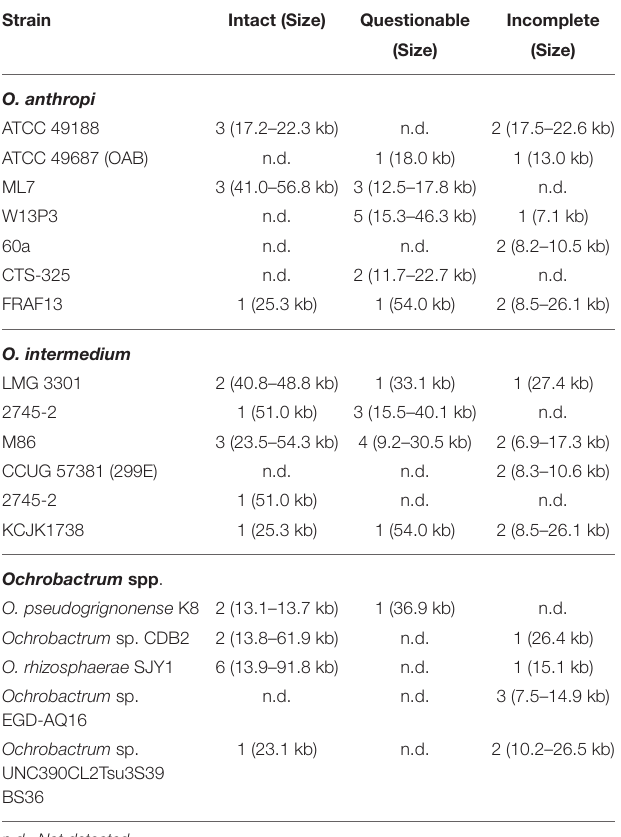
TABLE 2 | Prophage content of published Ochrobactrum sp. genomes. Strain Intact